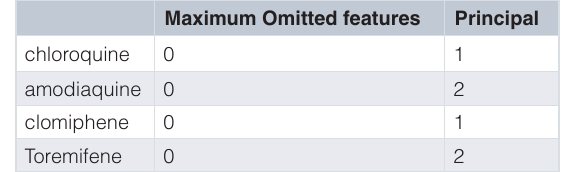
Supplementary materials Supplemental Table 1. Information for common features pharmacophore